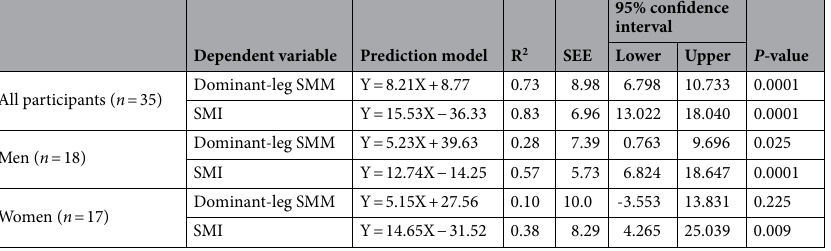
Table 3. Prediction models of 1RM for leg-press using BIA measurements. 1RM one-repetition maximum, BIA bioelectrical impedance analysis, SEE standard error of estimation, SMI skeletal muscle mass index, SMM skeletal muscle mass.